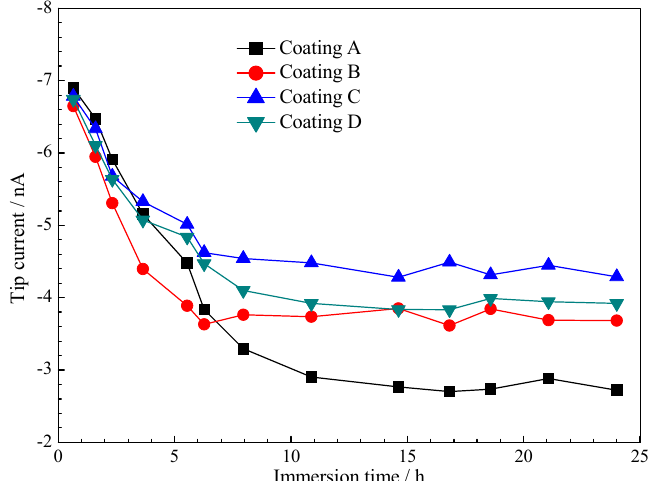
This result indicates that the GLYMO silane component has an inhibitory effect on the silicone-epoxy coating.